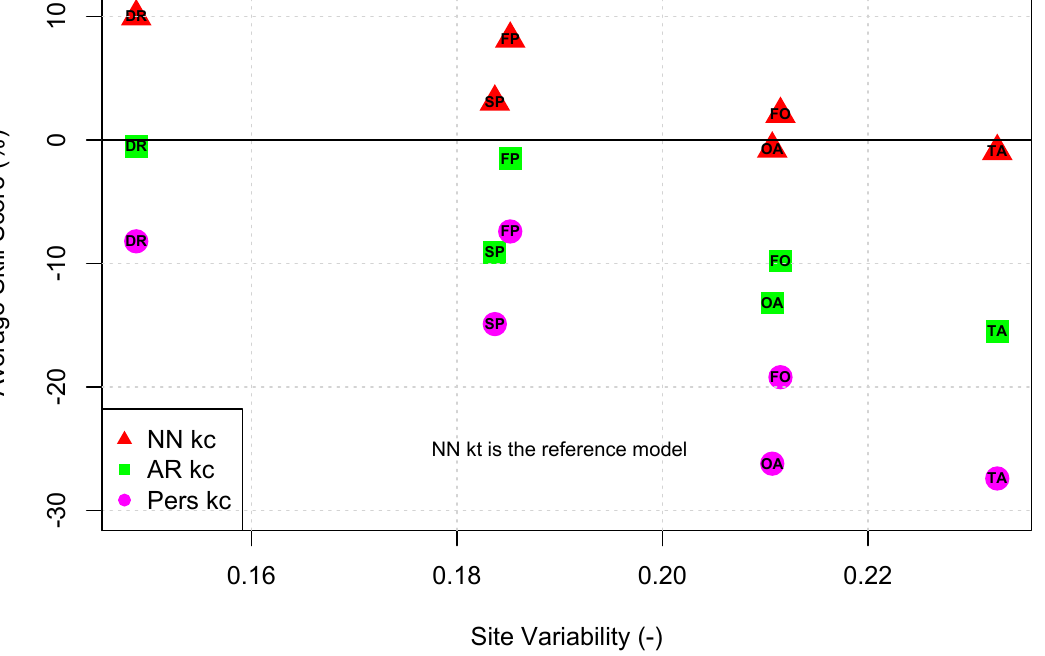
Figure 6. Skill scores of the three forecasting methods based on the clear sky index vs. variability of the site. The reference model used to compute the skill score is the “NN kt” model. Note that scored are averaged over all six forecast horizons (1 h to 6 h